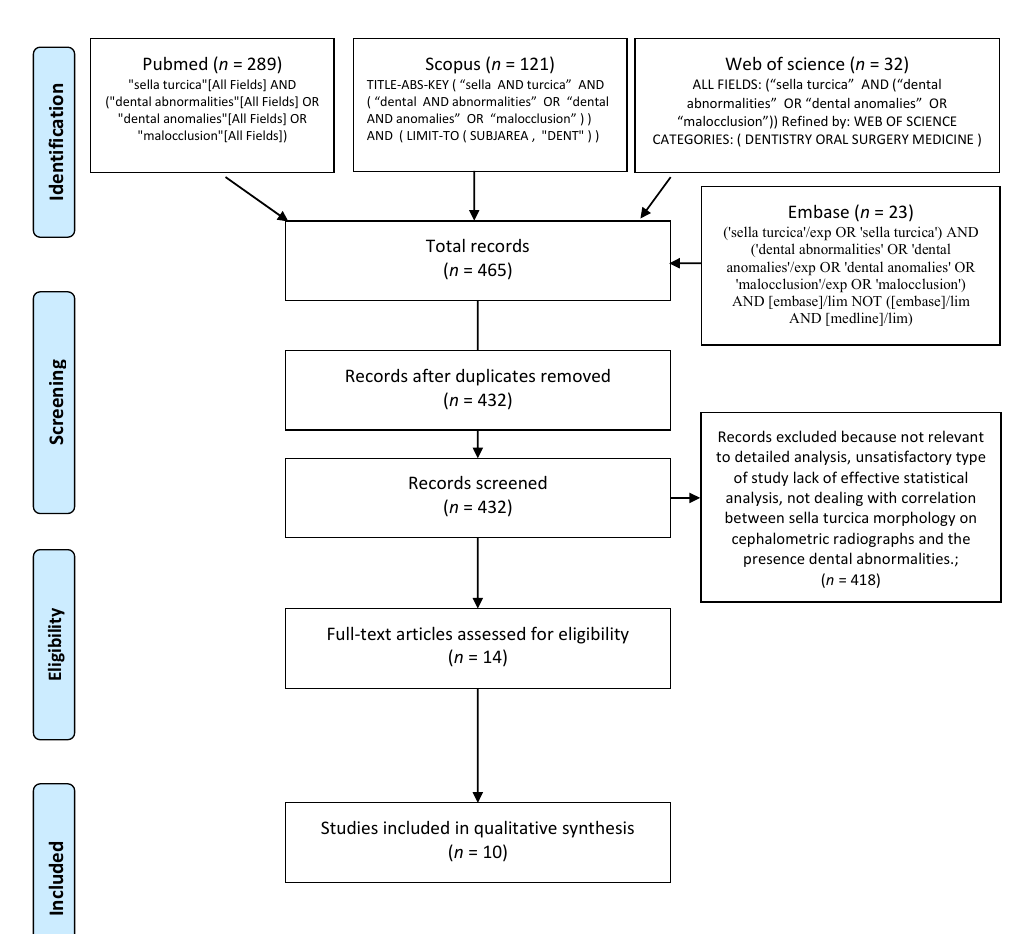
Figure 1. Prisma 2009 flow diagram.